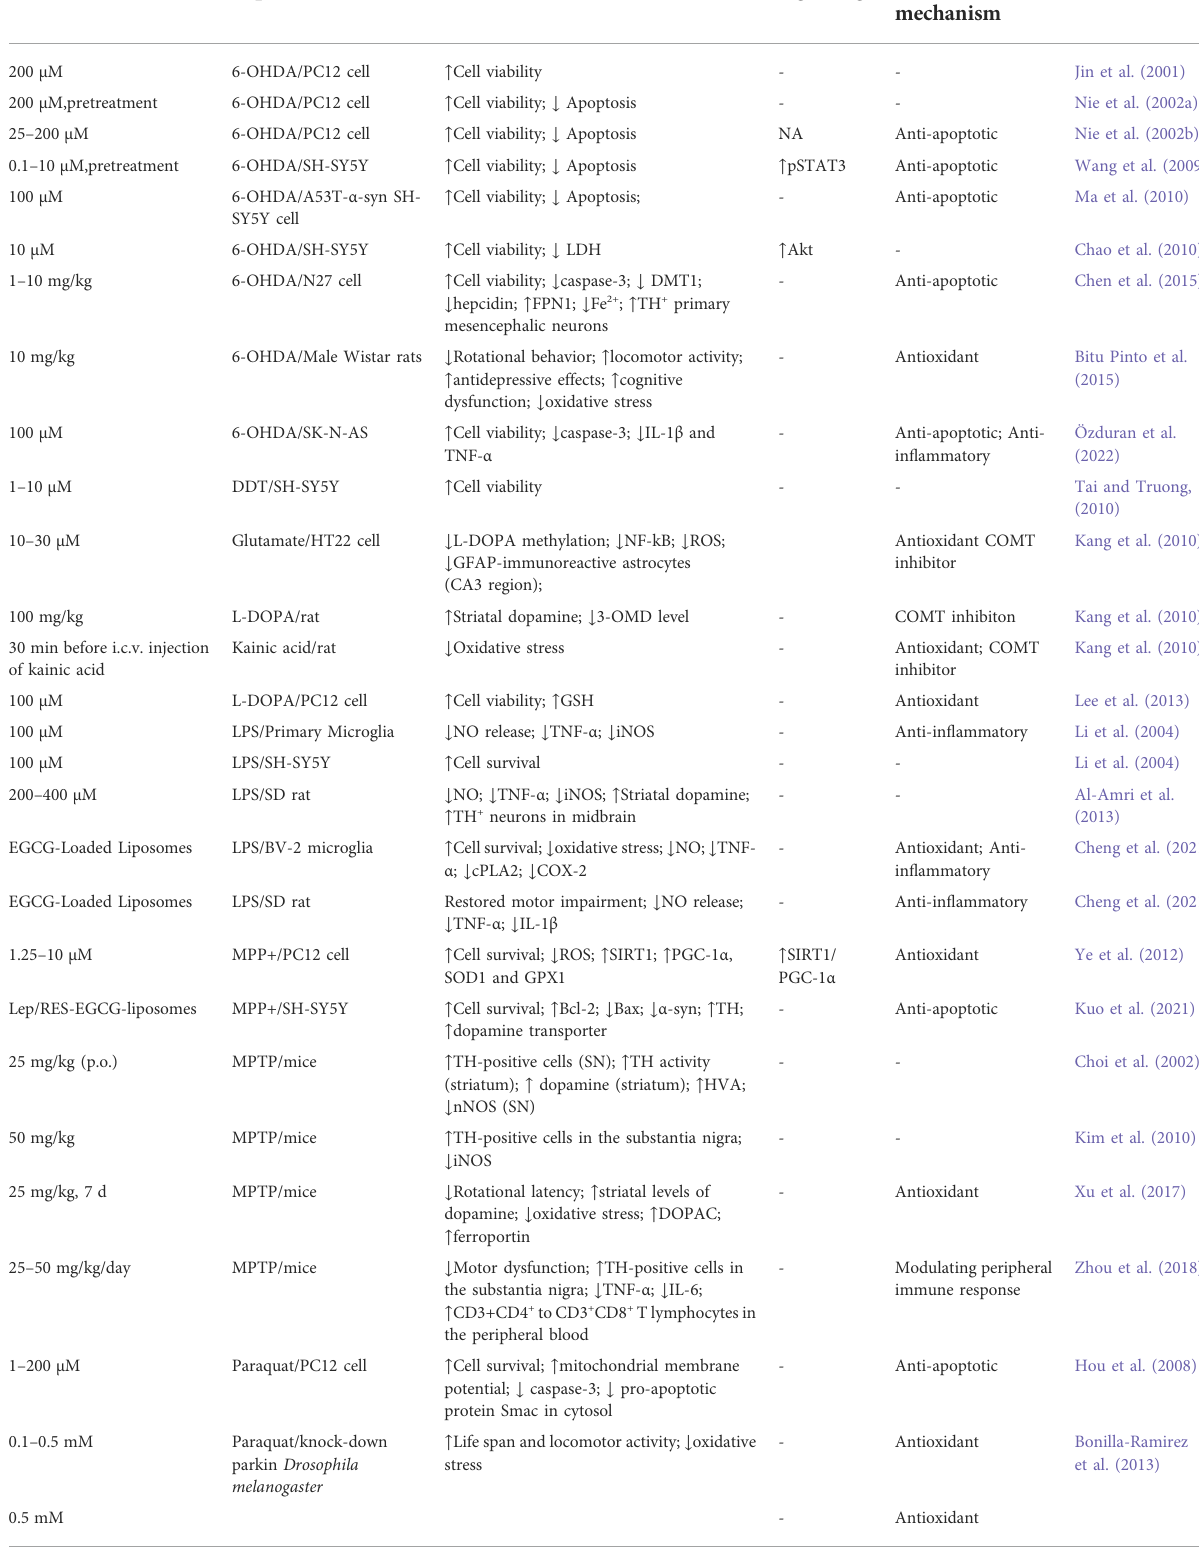
TABLE 1 Neuroprotective effects of EGCG in